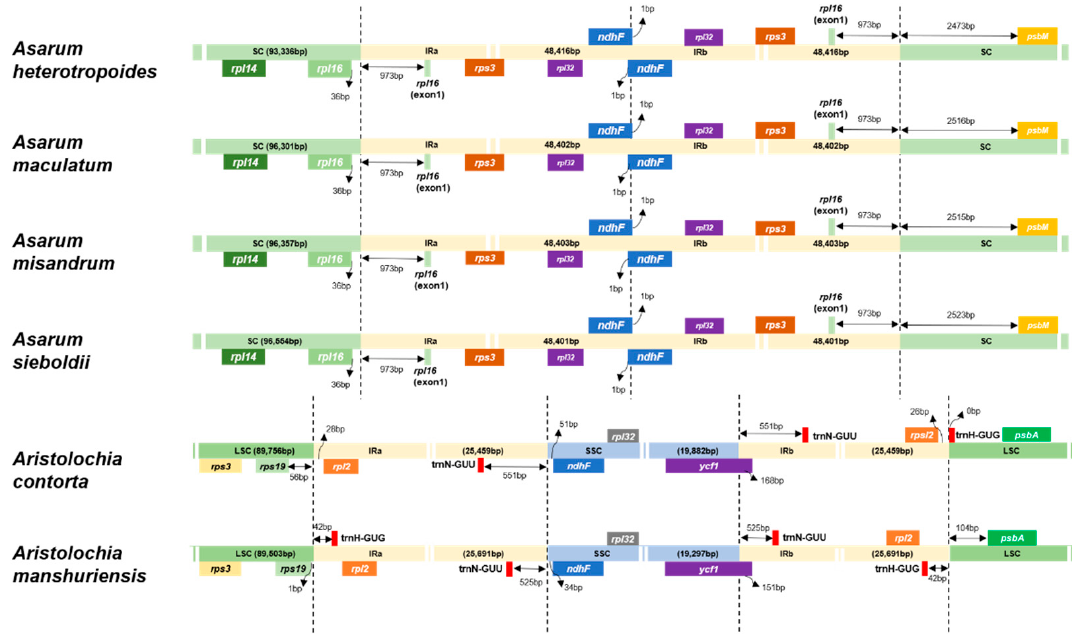
Figure 2. Comparison of the boundaries between regions within the plastome. Each region is represented as a bar: Large single copy (LSC) (including SC), pale-green; inverted repeat (IR), pale-yellow; small single copy (SSC), pale-blue. The genes on the bar are transcribed (from left to right), whereas the genes under the bar are transcribed (from right to left).